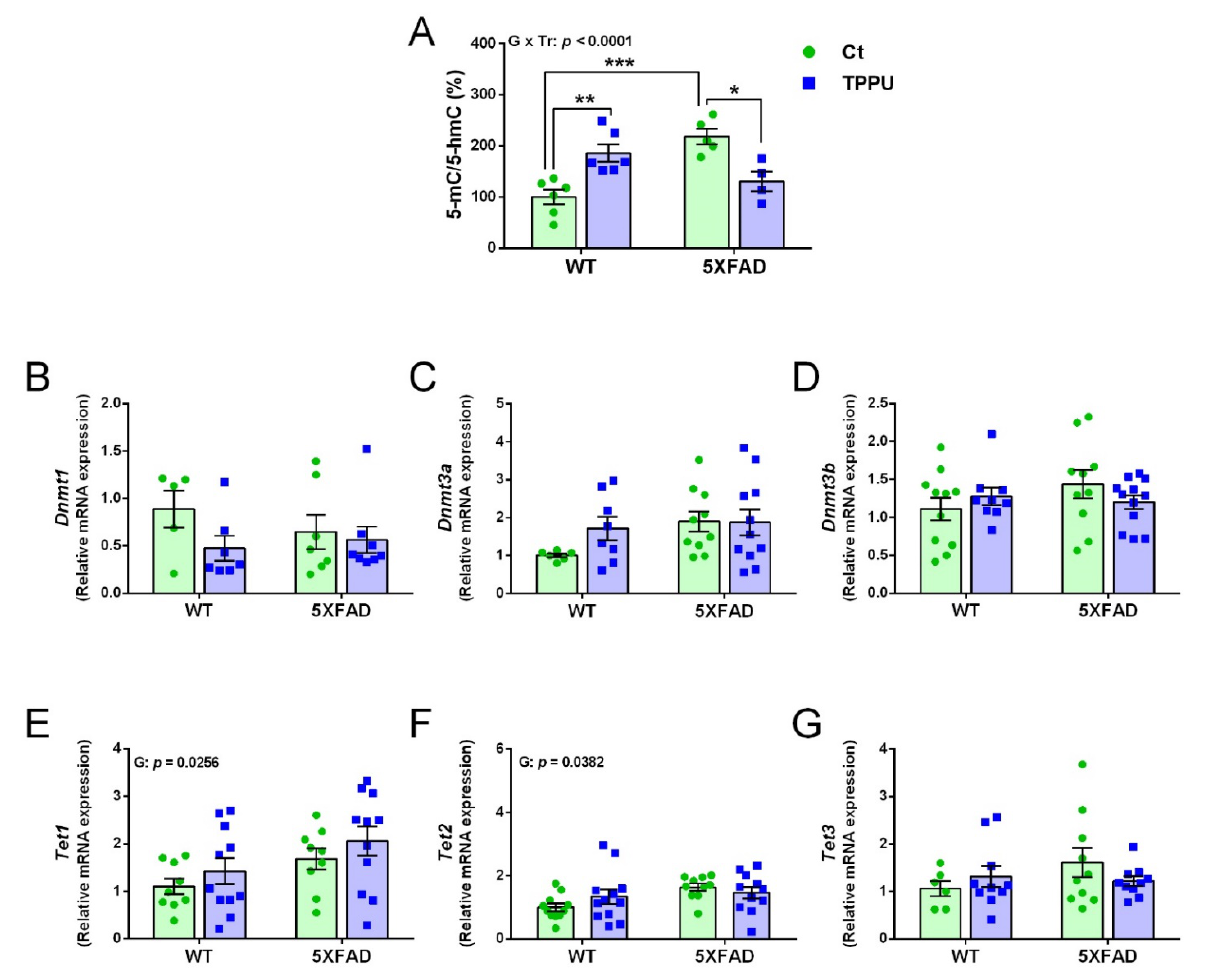
Figure 3. DNA methylation and demethylation changes in 2-month-old WT and 5XFAD mice from litters with maternal TPPU treatment or control (Ct). ( A ) Methylation profile obtained by the 5-methylcytosine (5-mC) and 5-hydroxymethylcytosine (5-hmC) ratio (%); ( B – D ) expression levels of the DNA methyltransferase genes Dnmt1 ( B ), Dnmt3a ( C ), and Dnmt3b ( D ); ( E – G ) expression levels of the methylcytosine dioxygenase genes Tet1 ( E ), Tet2 ( E ), and Tet3 ( G ). ( A – G ) Cerebral cortex samples. Values are mean ± SEM of male and female mice (( A ) n = 4–6; ( B ) n = 5–8; ( C ) n = 6–11; ( D ) n = 9–12; ( E ) n = 9–11; ( F ) n = 10–12; ( G ) n = 7–10). Statistics: ANOVA, interaction genotype per treatment effect (G x Tr) in ( A ), effect of genotype (G) in ( E , F ), p values of the significant factor and factor interaction are indicated in the corresponding graphs; Bonferroni post-hoc test after a significant factor interaction, * p < 0.05, ** p < 0.01, *** p < 0.001 between groups as indicated.